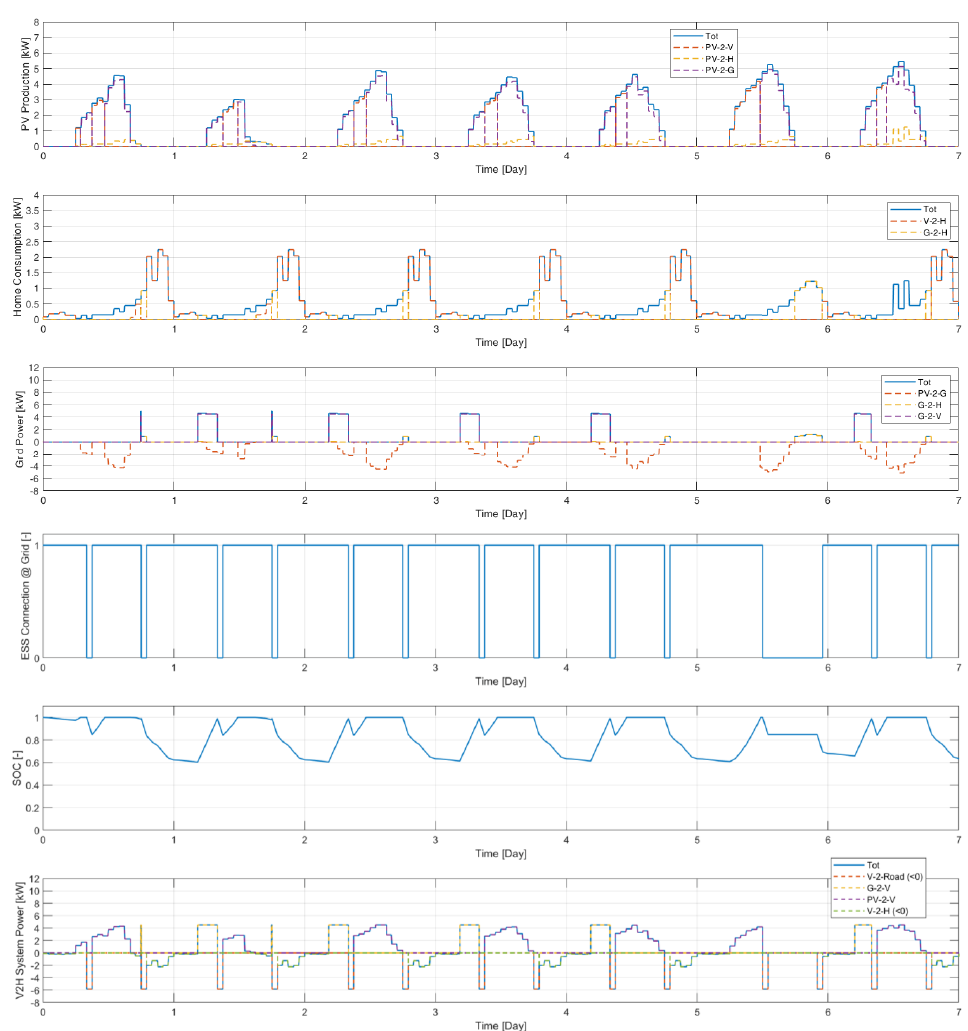
Figure 19. Summer week. Case2B — SW 2D results.